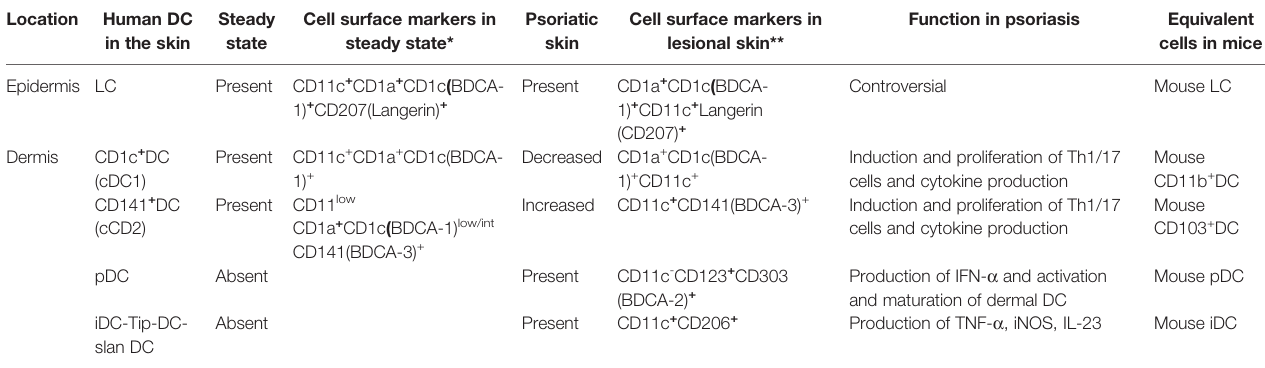
TABLE 2 | Human dendritic cells in the skin of normal individuals and in psoriatic skin. Location Human DC in the